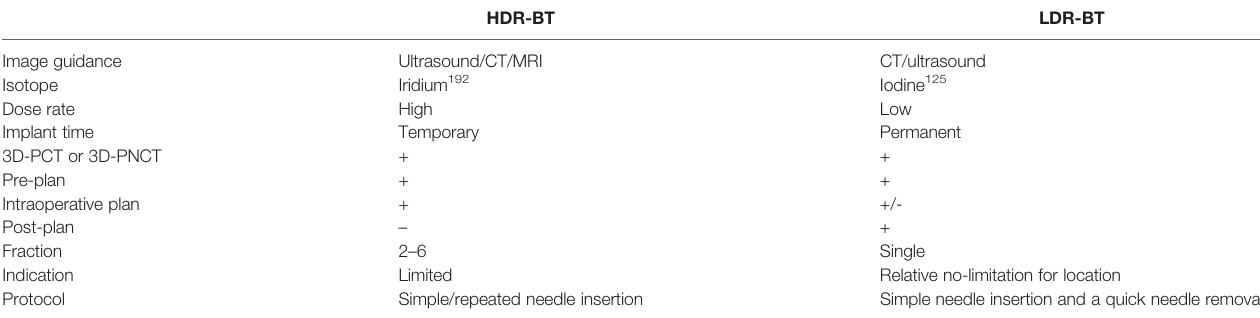
TABLE 1 | The characteristics of HDR-BT and LDR-BT.